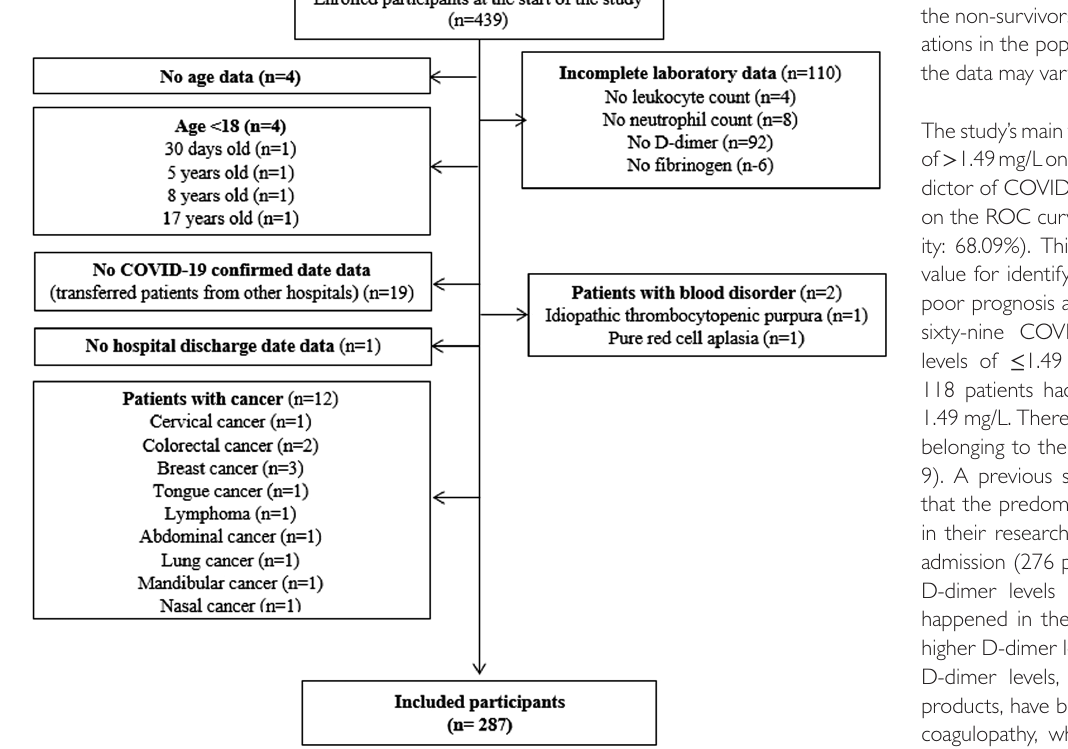
Figure 1. Study flow diagram on the numbers of participants enrolled and assessed during the study the sex and comorbidities-adjusted survival curve between the patients with D-dimer lev- els of > 1.49 mg/L and less than or equal to 1.49 mg/L. The unadjusted Kaplan–Meier plot is also provided in Supplementary Figure 1. The ROC curve for D-dimer’s predictive role on patient death demonstrated 82.69% sensitivity and 68.09% specificity at the 1.49 mg/L cut-off. This graph’s area under curve (AUC) was 0.786 ( P < .001).